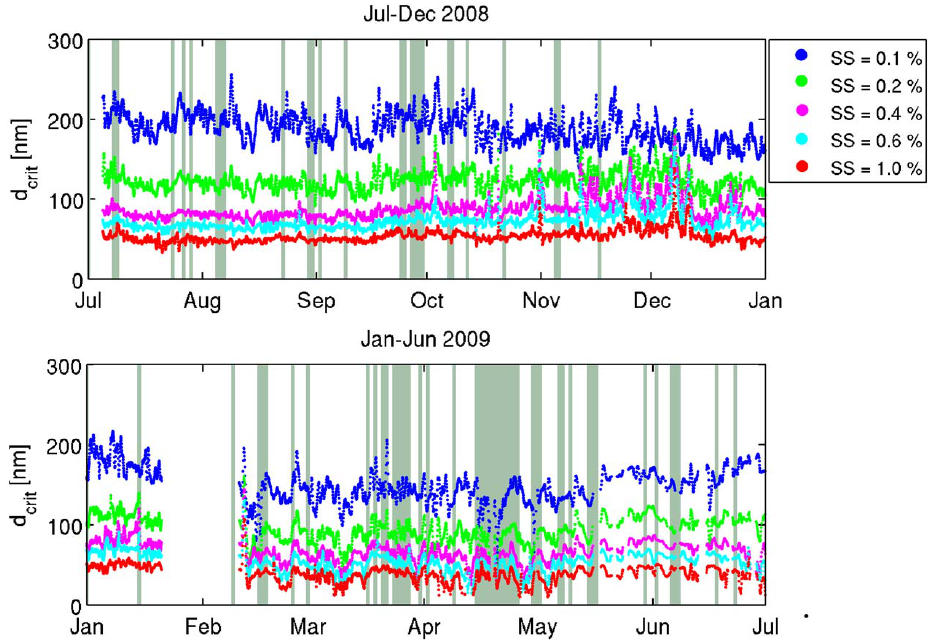
Fig. 3. Time evolution of critical diameter, estimated from CCNC data and particle size distribution data. Different colours correspond to five supersaturation ( SS ) levels: 0.1% (blue), 0.2% (green), 0.4% (purple), 0.6% (light blue), 1.0% (red). The data points are 1h averages which have been smoothed by taking a moving average with a 10 points window. Days with new particle formation (event days) are marked with a grey background.